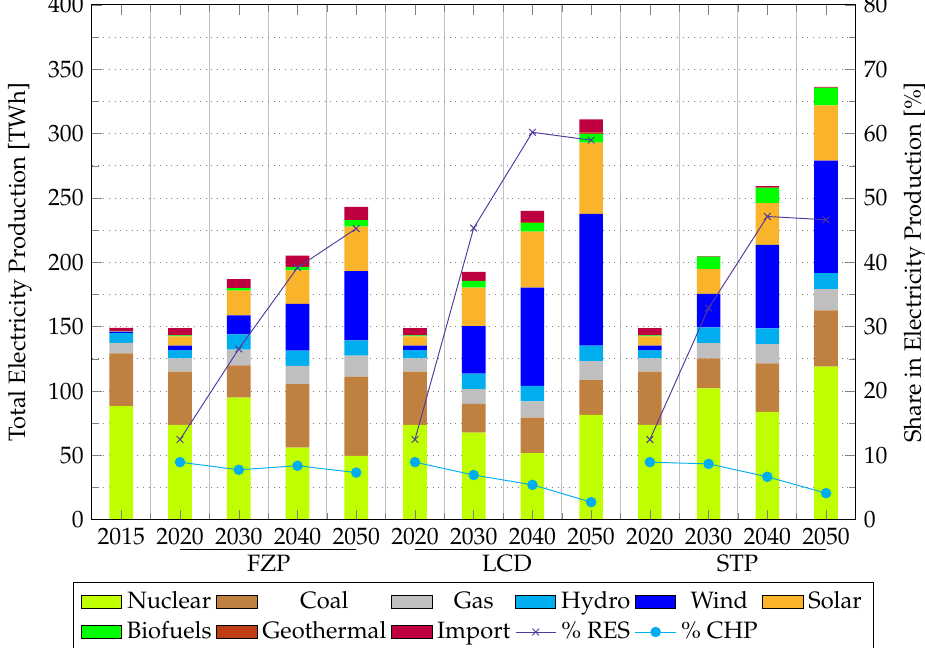
Figure 2. Total electricity production by fuel type for three main scenarios. The district heating (DH) production in the FZP scenario will increase by more than 50% until 2050 compared to 2020, while the LCD and STP scenarios go in different direction (Figure 3). The DH production will decrease in these scenarios by around 5% in the same period. The reason for the decrease is cost-effective thermal insulation of buildings which is reducing heat production of all heat supply options, including